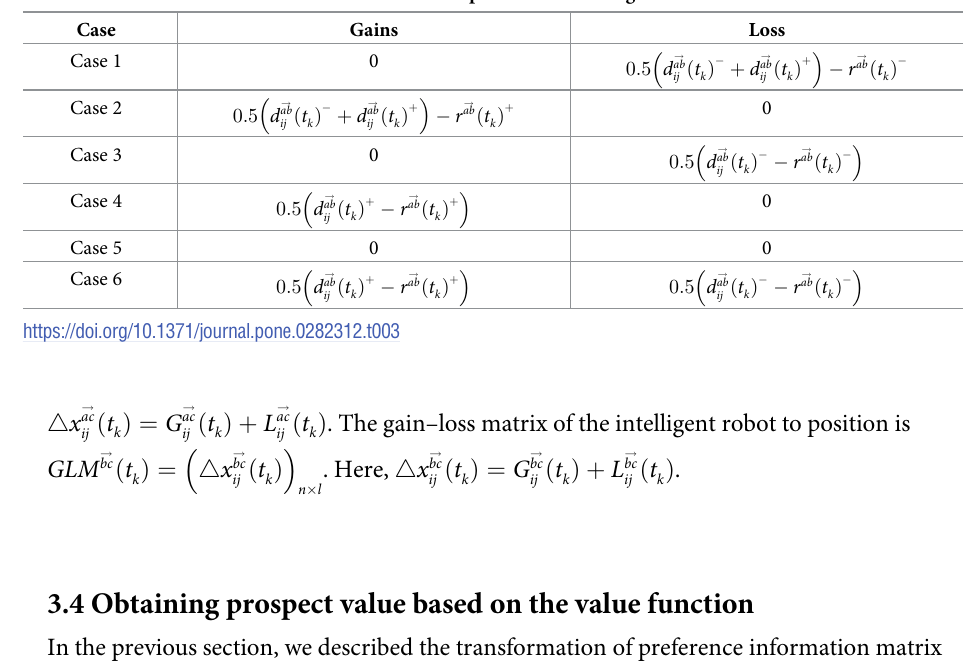
Table 3. Calculation formula of benefits and losses of personnel to intelligent